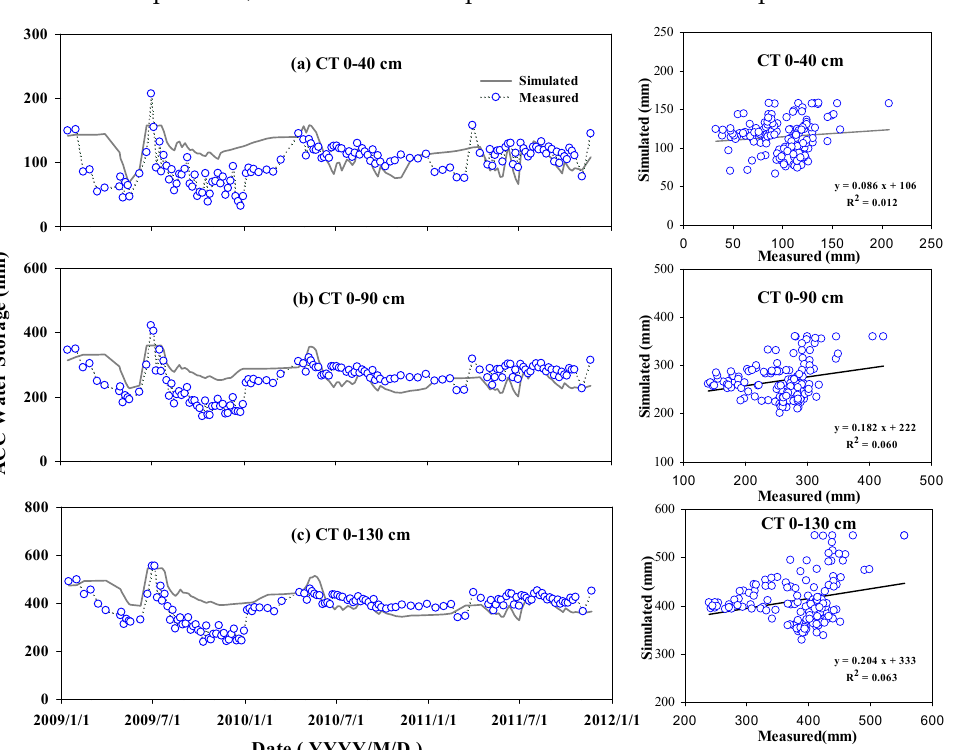
Figure 5. Simulations vs. measurements of water storage at ( a ) 0–40 cm, ( b ) 0–90 cm, and ( c ) 0–130 cm for NT during 2009–2011.